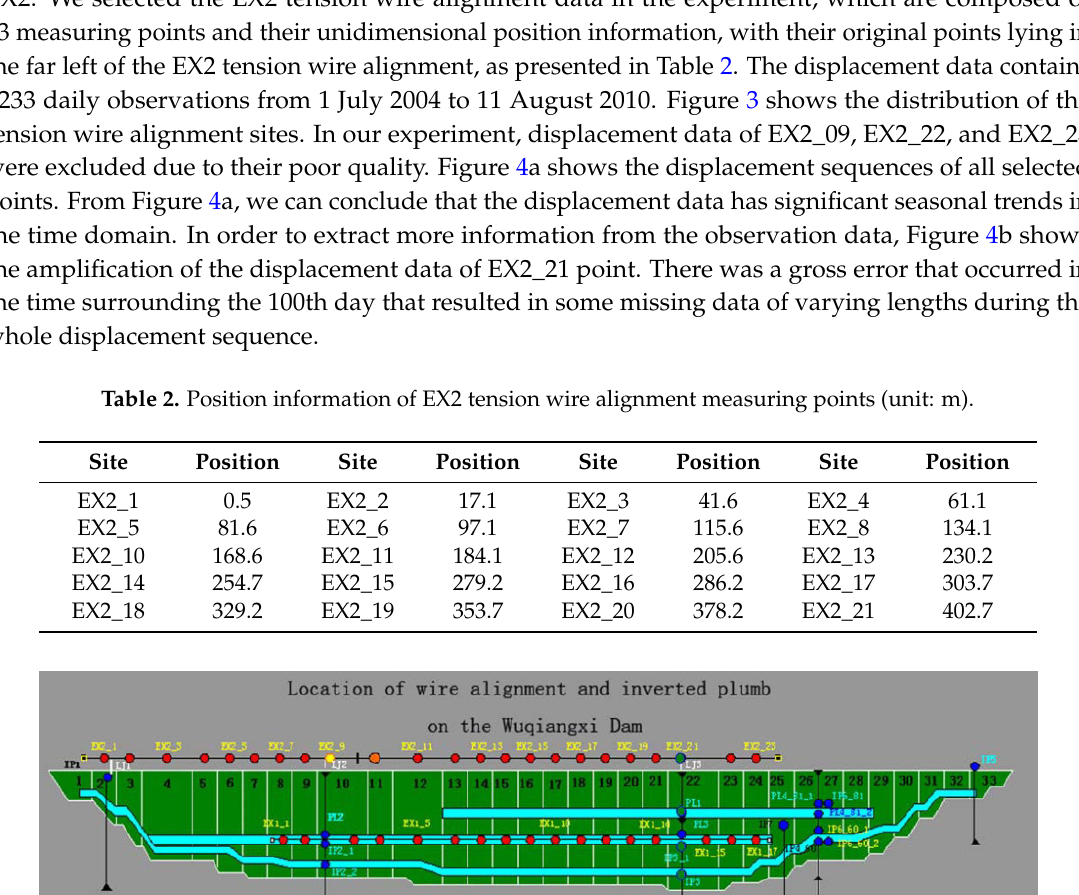
Table 1. (cid:1844)(cid:1839)(cid:1845) (cid:2869) of Interpolation, Filter, and Prediction of each point (unit: mm). Interp, Interpolation; Pred, Prediction.